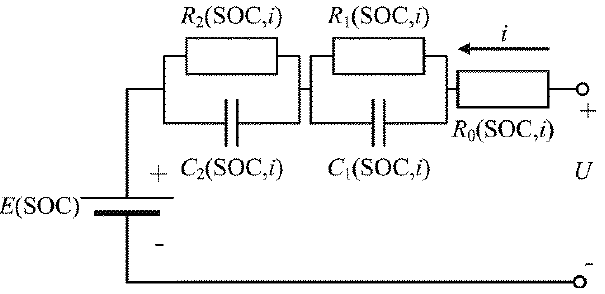
Figure 4. Modified the second ‐ order Thevenin equivalent circuit model.